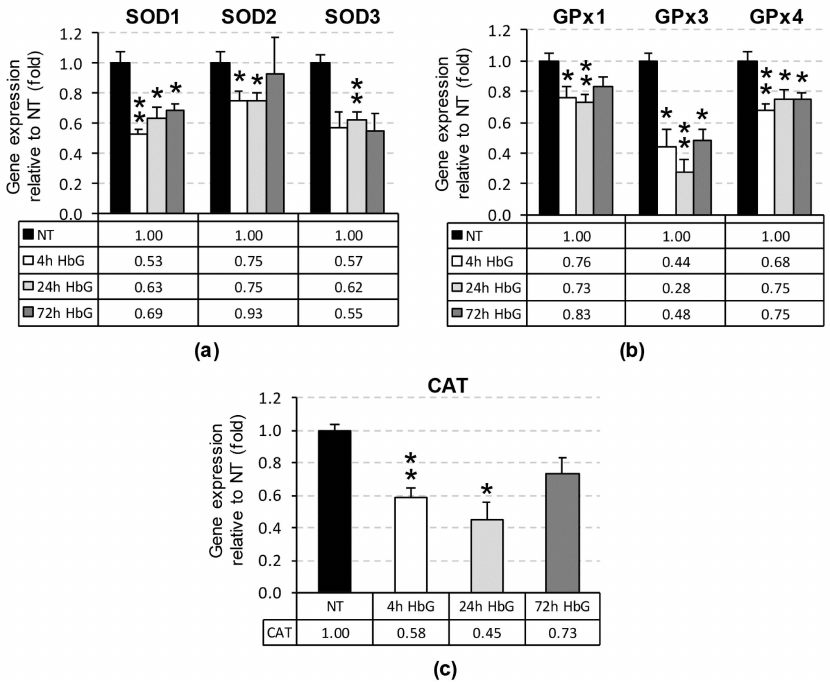
Figure 1. Renal antioxidant gene mRNA levels following infusion with HbG. The relative mRNA levels of SOD1-3 ( a ); GPx1, GPx3, and GPx4 ( b ); and CAT ( c ) were assessed by qPCR as described in “Materials and methods” after 4, 24, and 72 h post-ET. The reference value reported as fold change normalized to GAPDH and relative to NT, equals 1. Values are means ˘ standard error (SE) from 3 to 5 animals per group. Asterisks indicate significant differences compared to NT (* p < 0.05, ** p < 0.01). NT: sham-operated no treatment group.